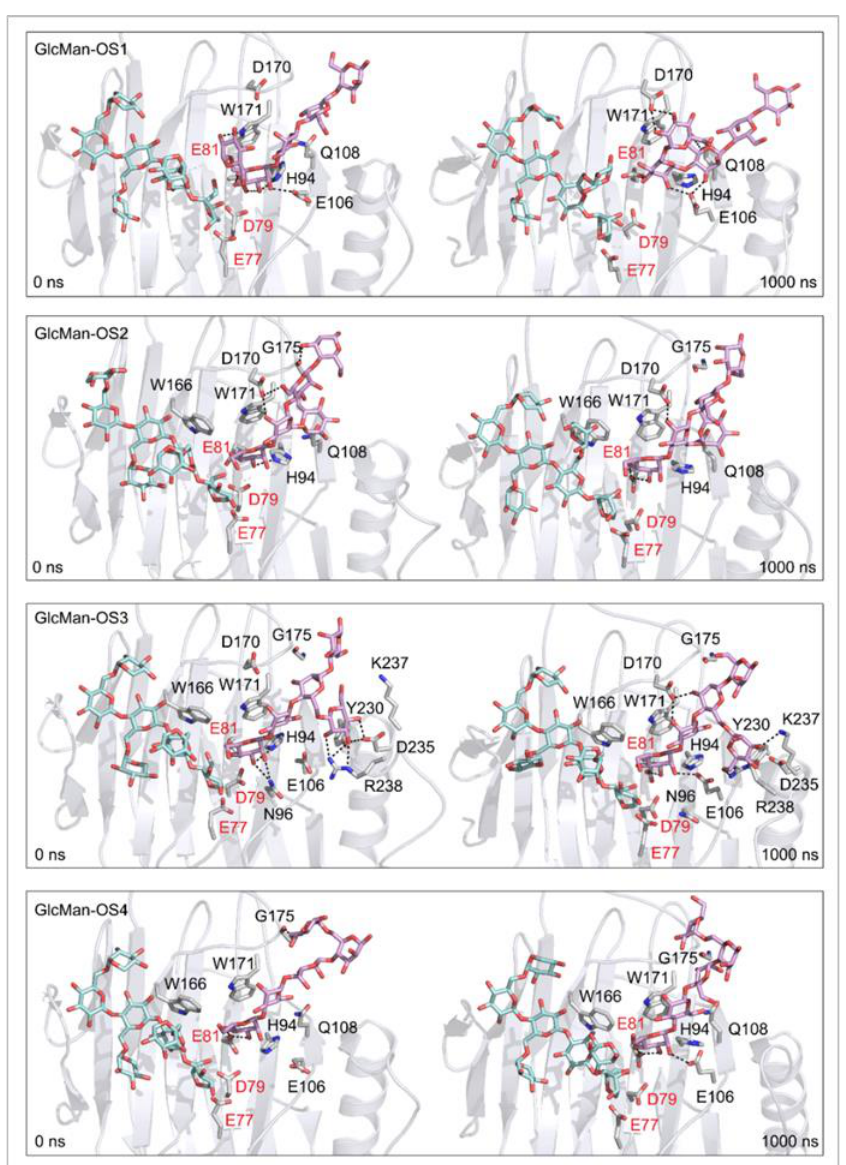
Figure 9. Positions of the XG-OS7 donor and docked GlcMan-OS acceptor substrates that interact with the TmXET6.3 residues (interactions shown at the acceptor sites). The residues that interact with acceptors over 50% of MD simulation times at distances of up to 4.0 Å (right, black letters) are shown at the beginning (0 ns) and after 1000 ns of MD simulation times. Catalytic residues are shown in red letters. Table 8. The TmXET6.3 residues that interact with AraXyl-OS and GlcMan-OS acceptors over 50% of MD simulation times at distances of up to 4.0 Å .